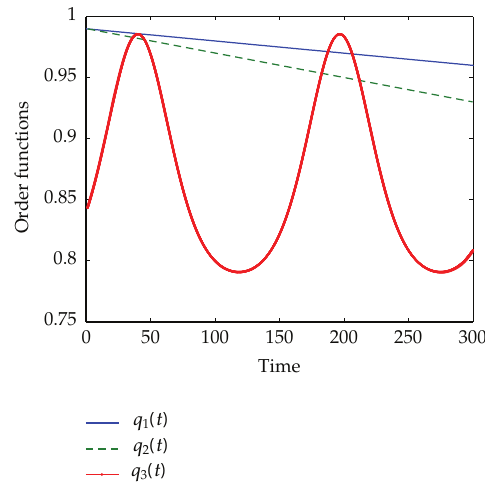
Figure 7: The nonlinear order functions in simulation.